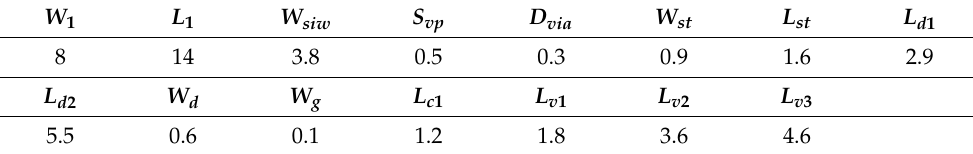
Table 1. The dimensions of the optimized folded dipole antenna. (Unit: mm).